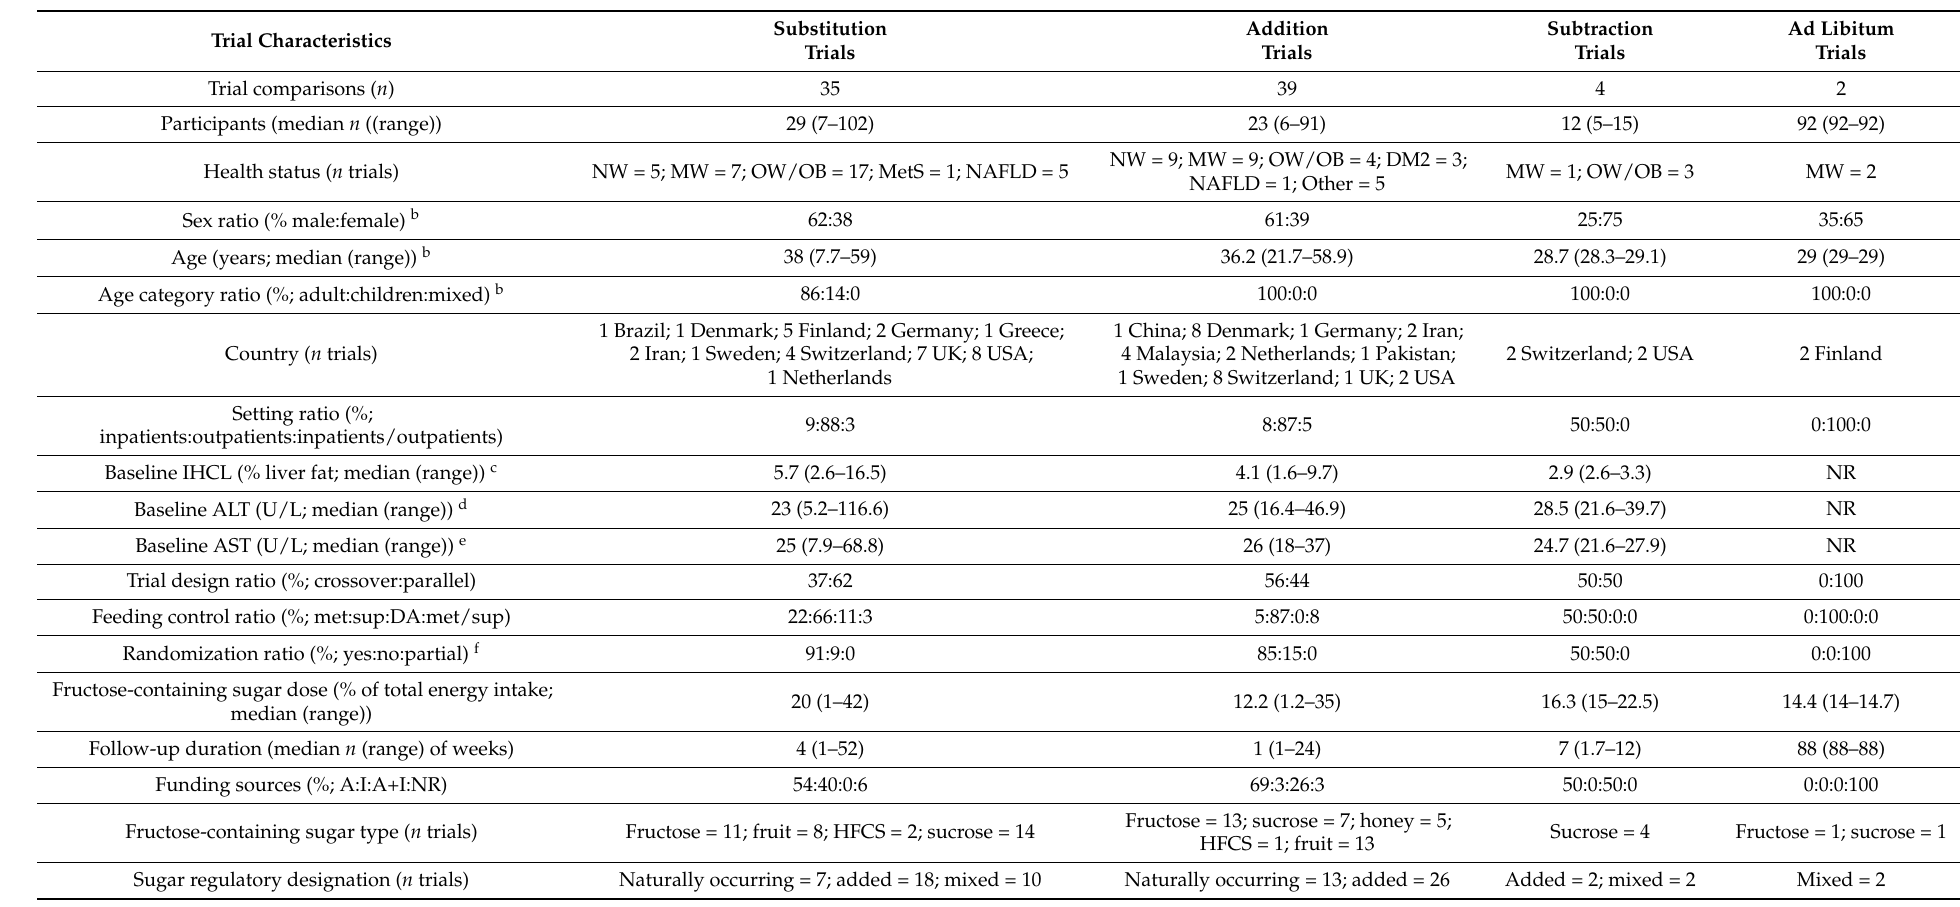
Table 1. Summary of trial characteristics a